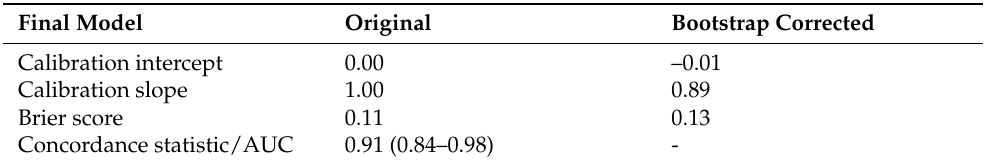
Table 3. Calibration and internal validation test results before and after bootstrapping (samples n = 300). The area under the curve (AUC) is presented with a 95% confidence interval.